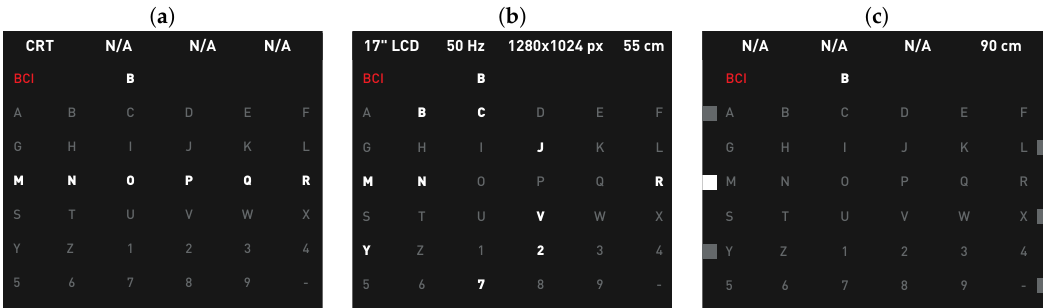
Figure 3. Graphical User Interface (GUI) of a modern P300 speller: ( a ) Matrix Speller inspired by the matrix developed by Farwell and Donchin in 1988 [7], shown during the intensification of the third row. ( b ) The random intensification similar to the one discussed in Yeom et al., 2014 [43]. ( c ) A view of the Edge Paradigm from Obeidat et al., 2015 [44] showing the intensification of the edge point next to the third row. All the above figures show “BCI” as the target word during spelling and “B” as an already selected character. Figures modified from the cited